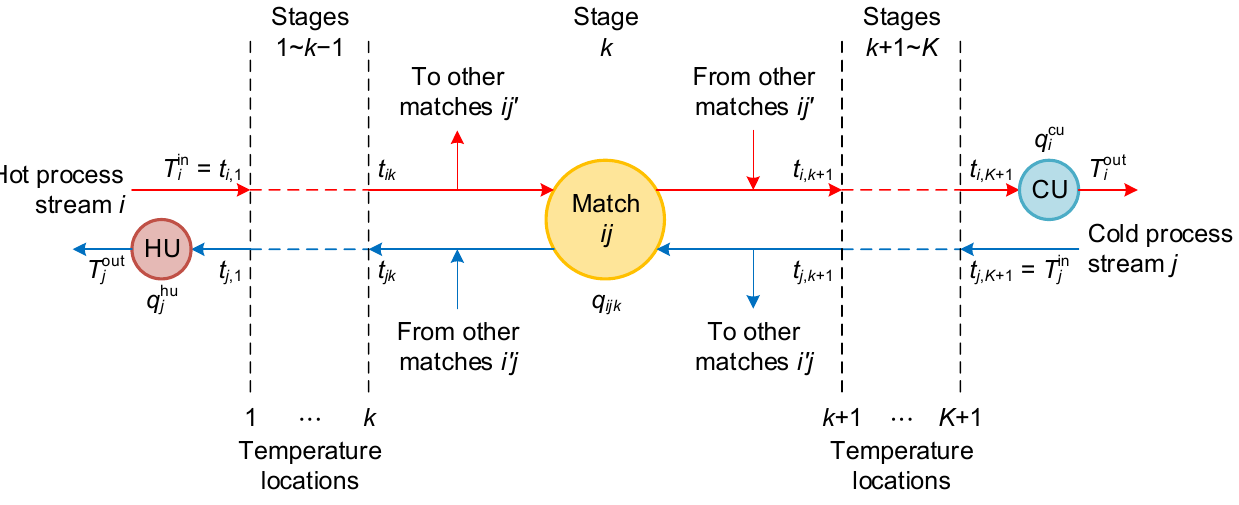
Figure 1. Stage-wise superstructure for a HEN.